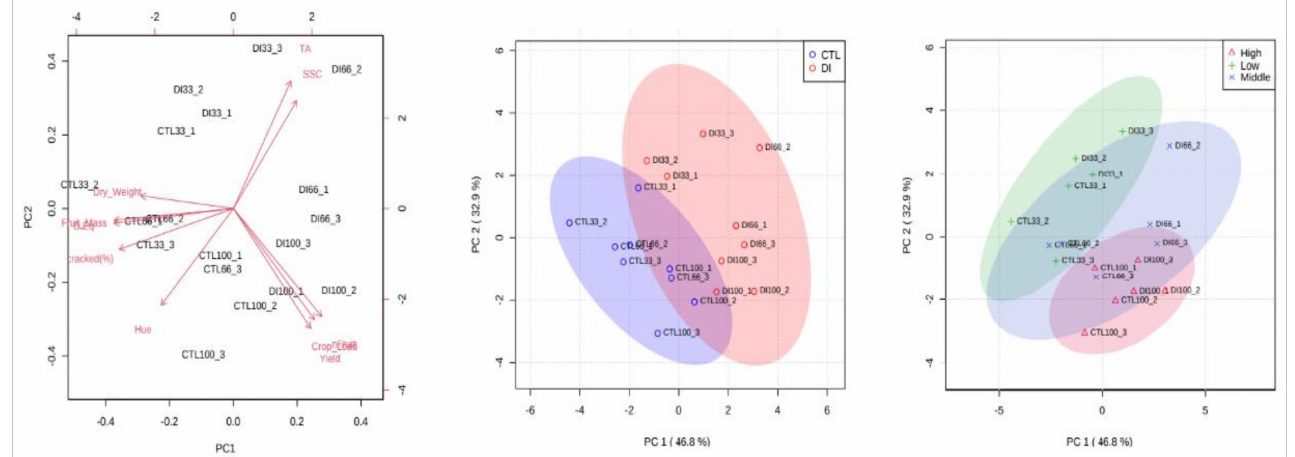
Figure 5. Principal component analysis (PCA) biplot of the fruit quality characteristics, expressed as vectors, of fruit from the two irrigation treatments, CTL (full irrigated treatment) and DI (deficit irrigation treatment), and the three levels of crop load: low (33%), medium (66%), and high (100%). The two principal components of the PCA explained 79.7% of the variation in the measured data.